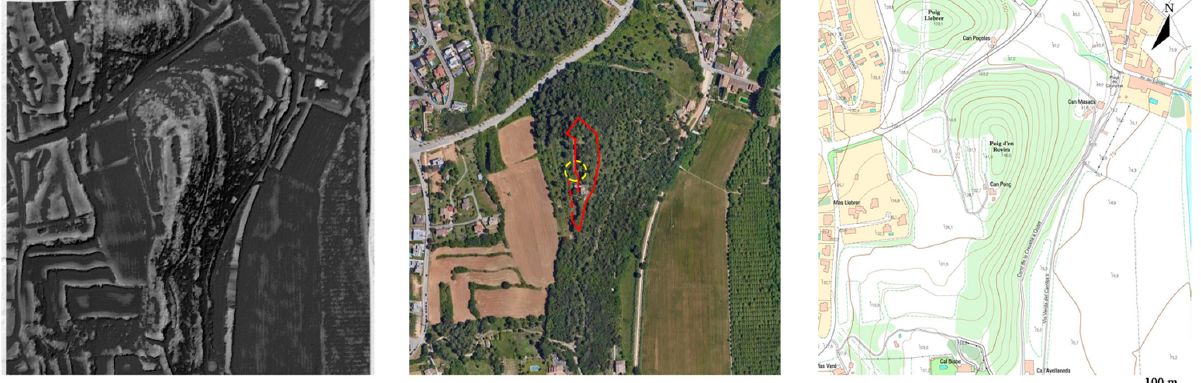
Figure 11. MSRM ( left ), satellite view ( centre ) and topographic map ( right , forest in green) of the Puig d’en Rovira site. In the satellite image the walls (red) and the known location of the settlement (yellow) are indicated.